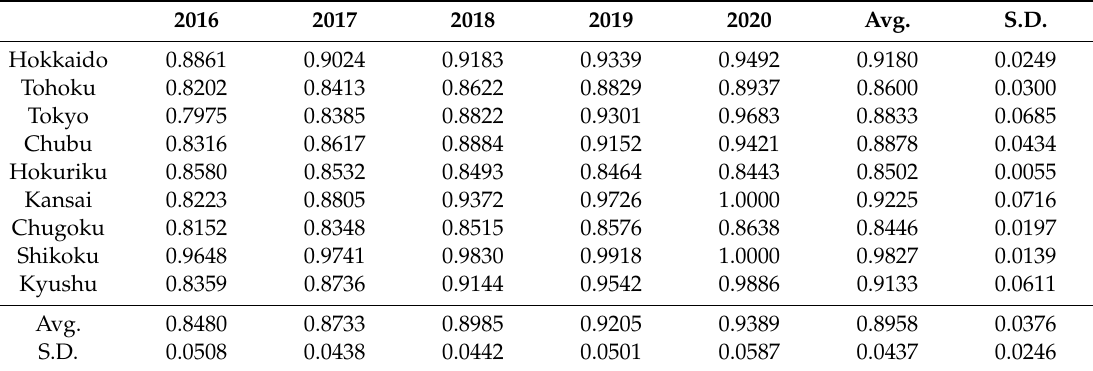
Table 9. Unified E ffi ciency of Electric Power Companies: Pooled Data